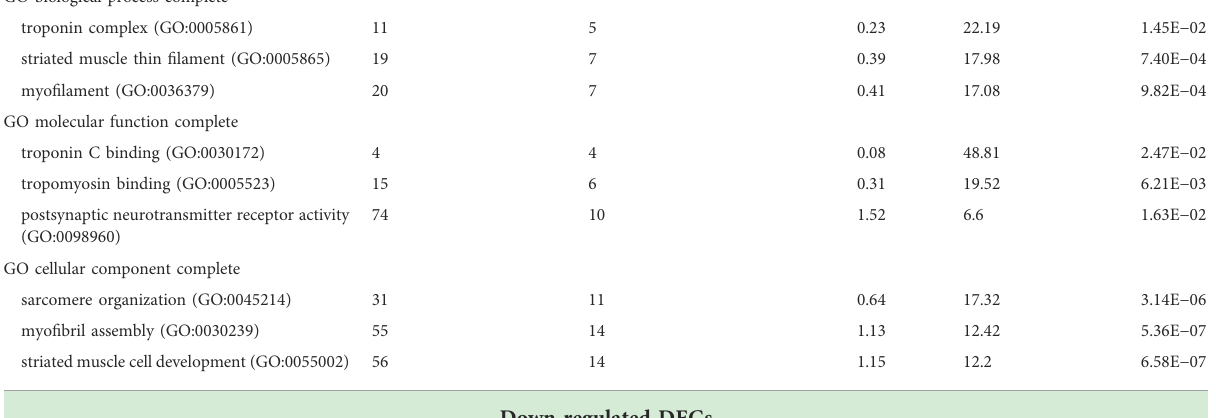
TABLE4PANTHEROverrepresentationtestof730DEGsintheNCTlinetemperaturecomparison(43 ° Cvs.38 ° C)after72 hofproliferation.Shownare the gene ontology categories with the greatest fold enrichment in each category for the up and down-regulated genes a